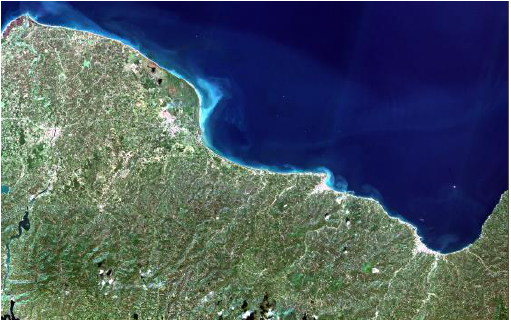
Figure 8. Pre-processed DS4 Sentinel-2 MSI image in true colour